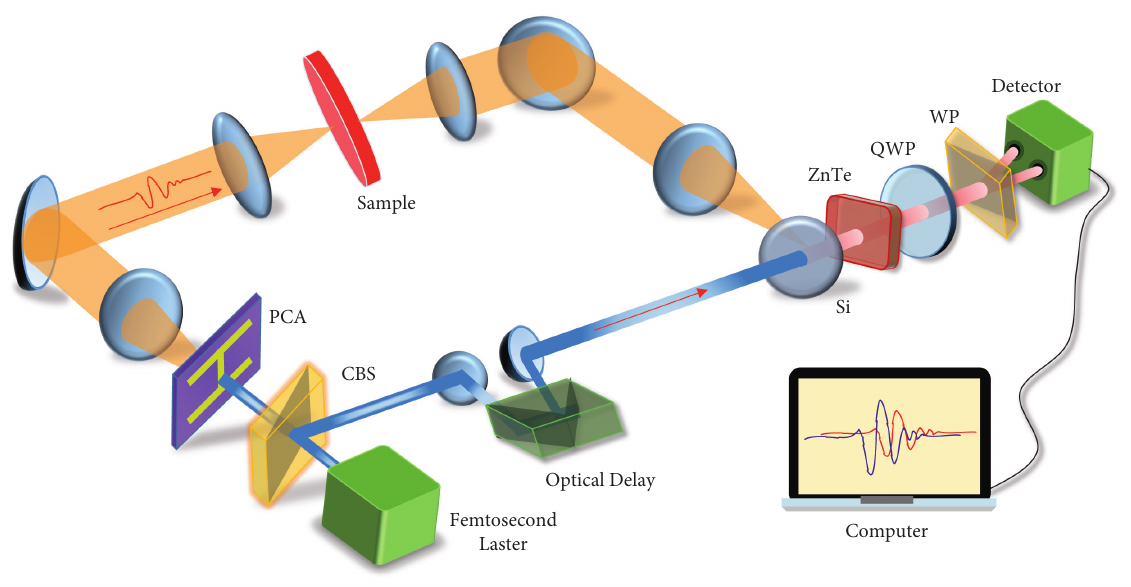
Figure 1: Schematic diagram of THz-TDS